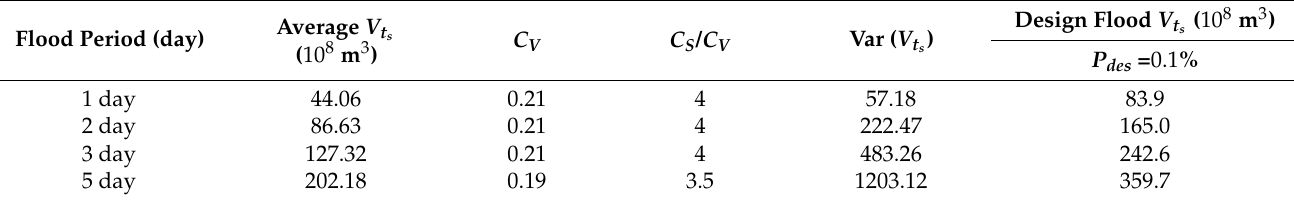
Table 1. The statistic parameters of the design maximum flood volumes within multiple time periods for Three Gorges Reservoir (TGR), where the means and variances of period flood volume are derived from historical daily flow series over the period 1882 to